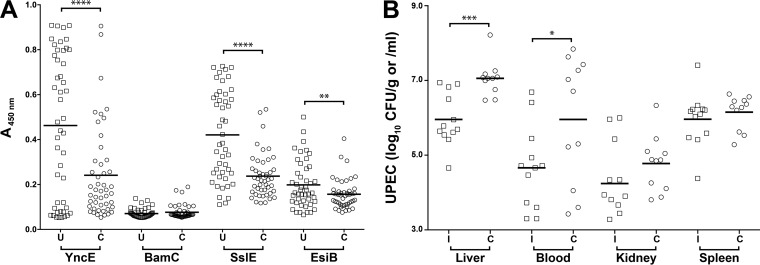
Immunoreactivity of plasma from urosepsis patients to E. coli vaccine antigens and bacterial burden following intravenous challenge in mice vaccinated with YncE. (A) Blood plasma was collected from 47 urosepsis patients (U) at least 4 days post-admittance to the hospital. IgG-specific antibody levels were compared to those from 47 healthy volunteers with no recent history of UTI (C). (B) Level of infection in immunized (I) and control (C) groups of mice at 24 h following intravenous challenge with UPEC strain CFT073. Symbols represent individual mice, and bars show the medians. The limit of detection was 200 CFU/g or CFU/ml. Statistically significant P values are indicated: ****, P < 0.0001; ***, P < 0.001; **, P < 0.01; *, P < 0.05.